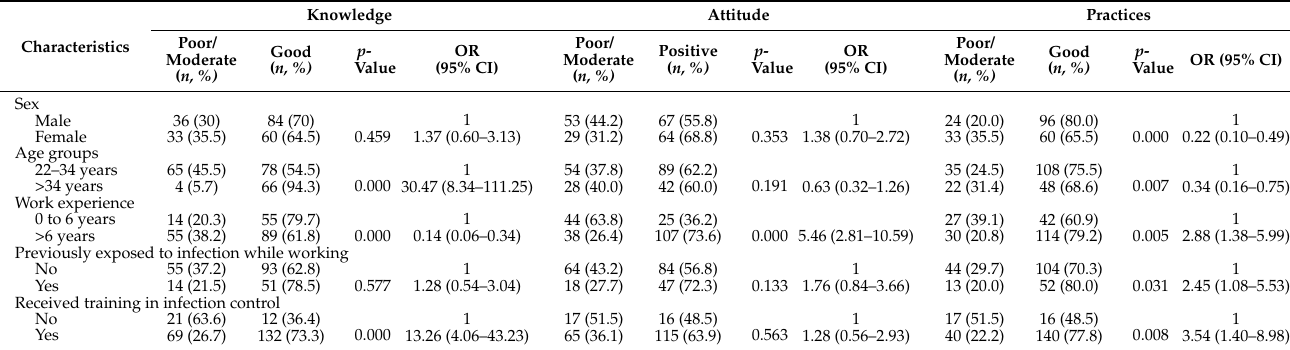
Table 5. Association between sociodemographic characteristics and level of knowledge, attitude, and practice of standard infection control precautions among HCWs, Qassim University Hospital, KSA.